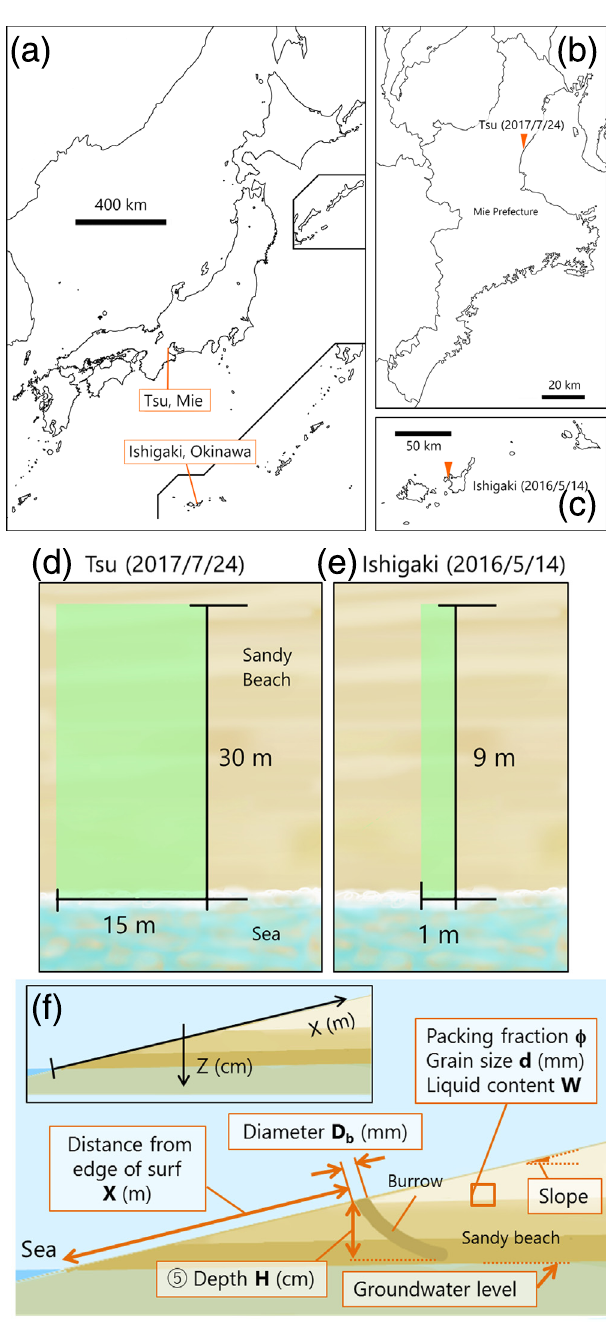
Fig 2. (a) Map of Japan with locations of Tsu, Mie Prefecture, Japan and Ishigaki, Okinawa Prefecture, Japan. Inset maps (b) of Tsu (Kawage Beach) and (c) Ishigaki (Sakieda Beach). Survey area dimensions at (d) Tsu and (e) Ishigaki. For Panel (f), we used the measured quantities and X - Z coordinate system (inset), where X denotes the slope distance from shoreline (along the surface of the beach). Z denotes the vertical distance (depth) from the surface to a given point at